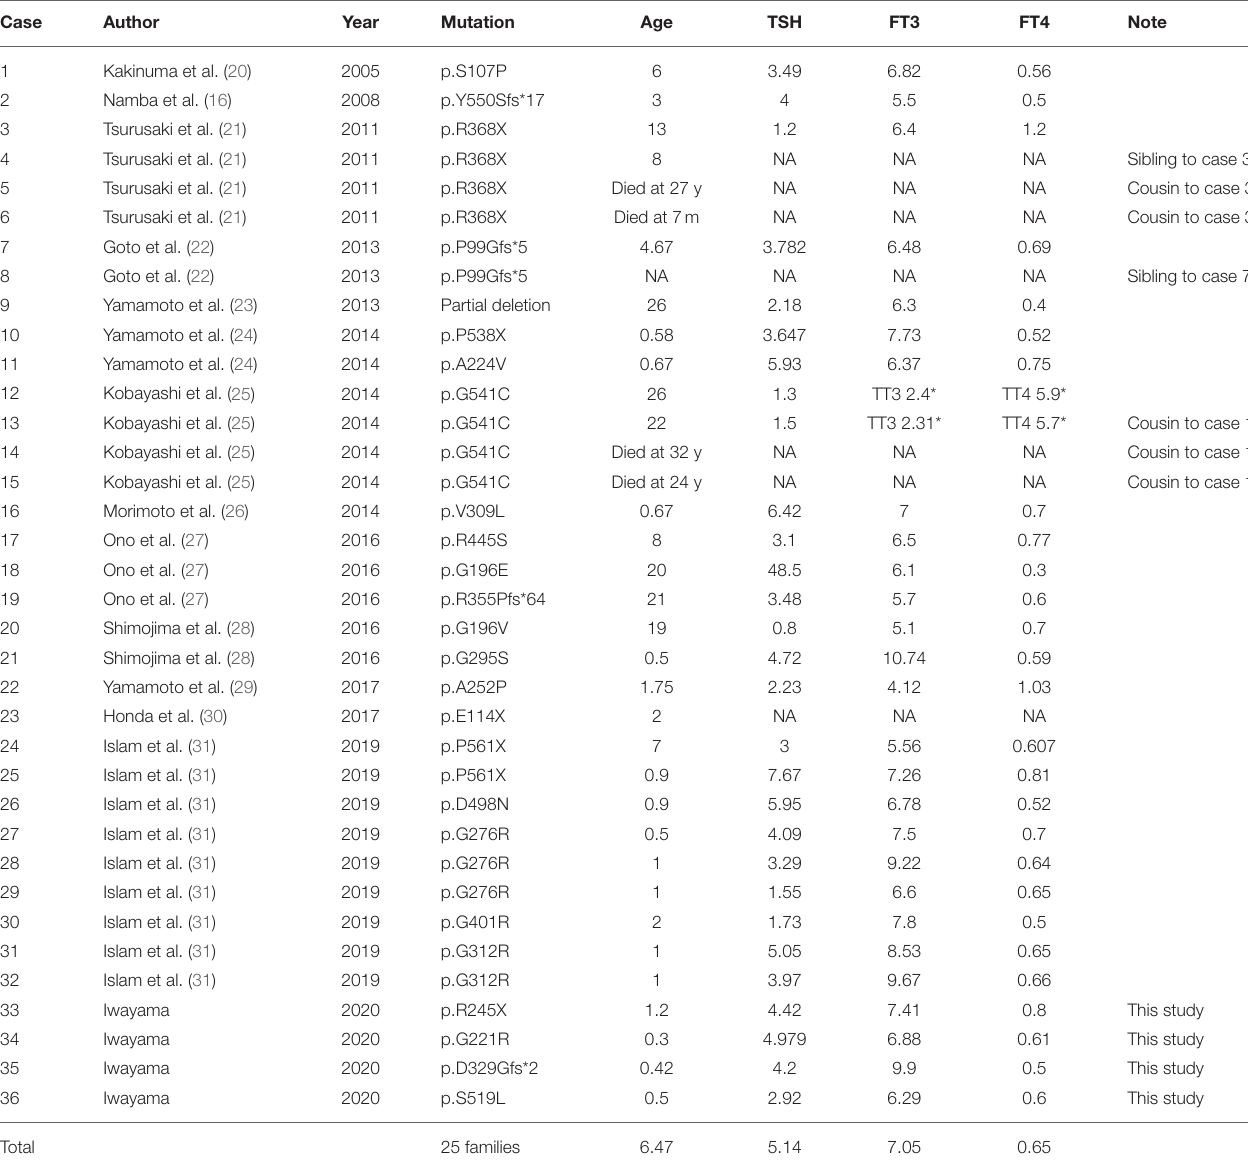
TABLE 2 | Summary of the previously reported Japanese patients with MCT8